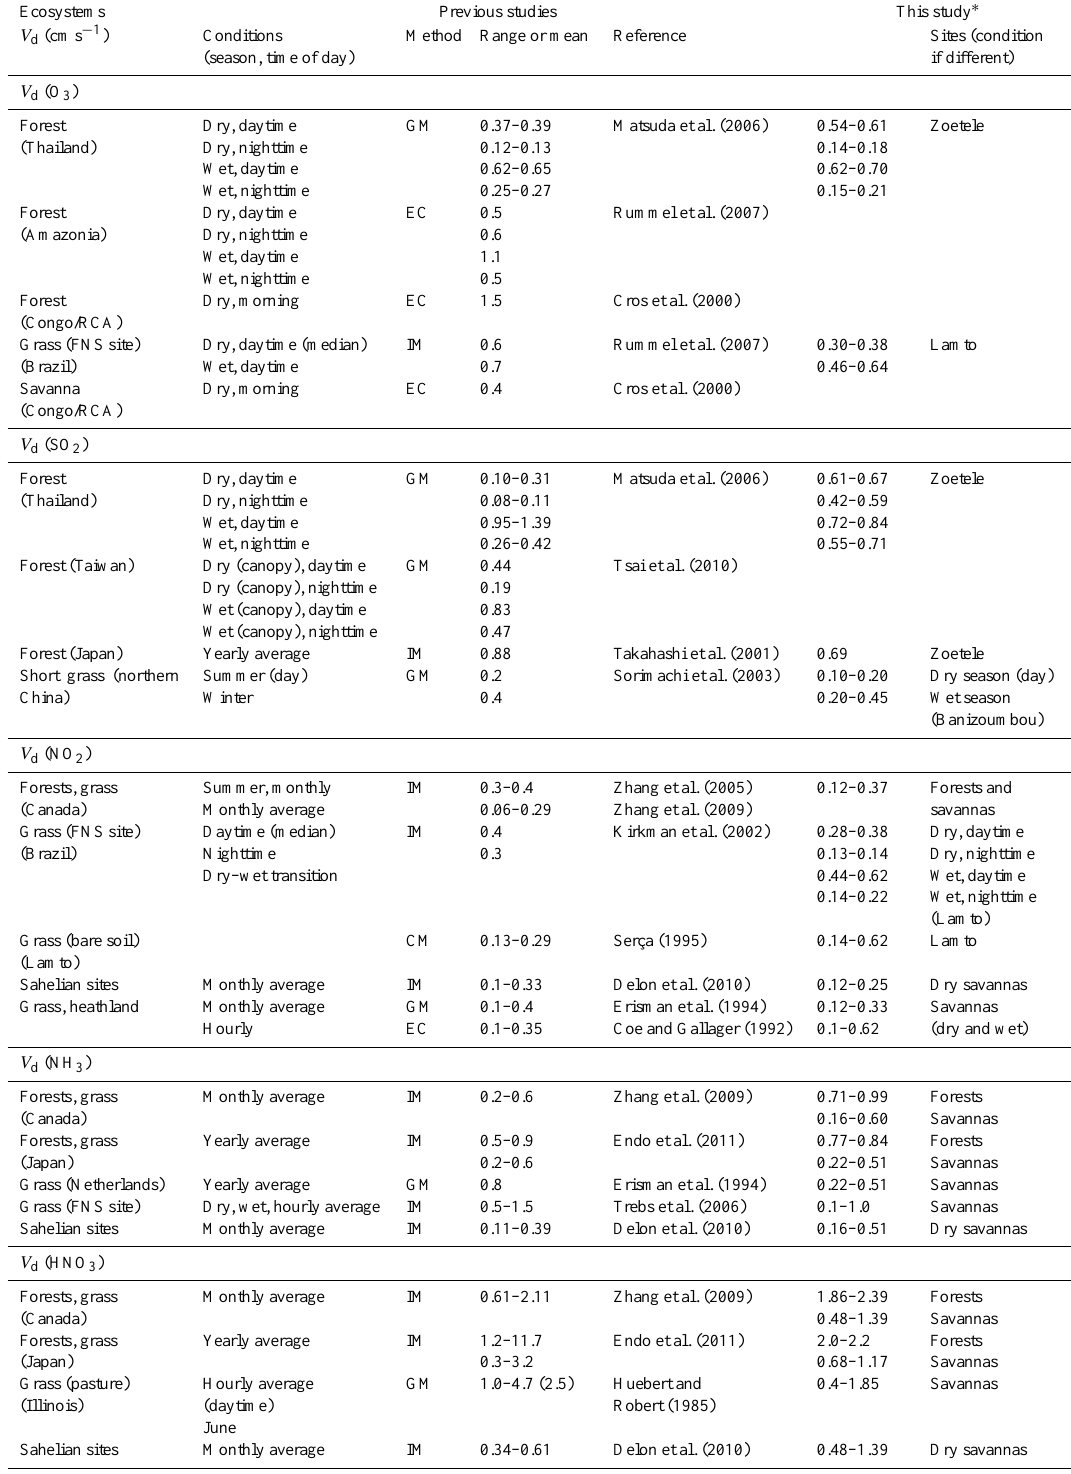
Table 4. Comparison of dry deposition velocities (cms − 1 ) for ozone, sulfur and nitrogen compounds between this study and previous studies. Ecosystems Previous